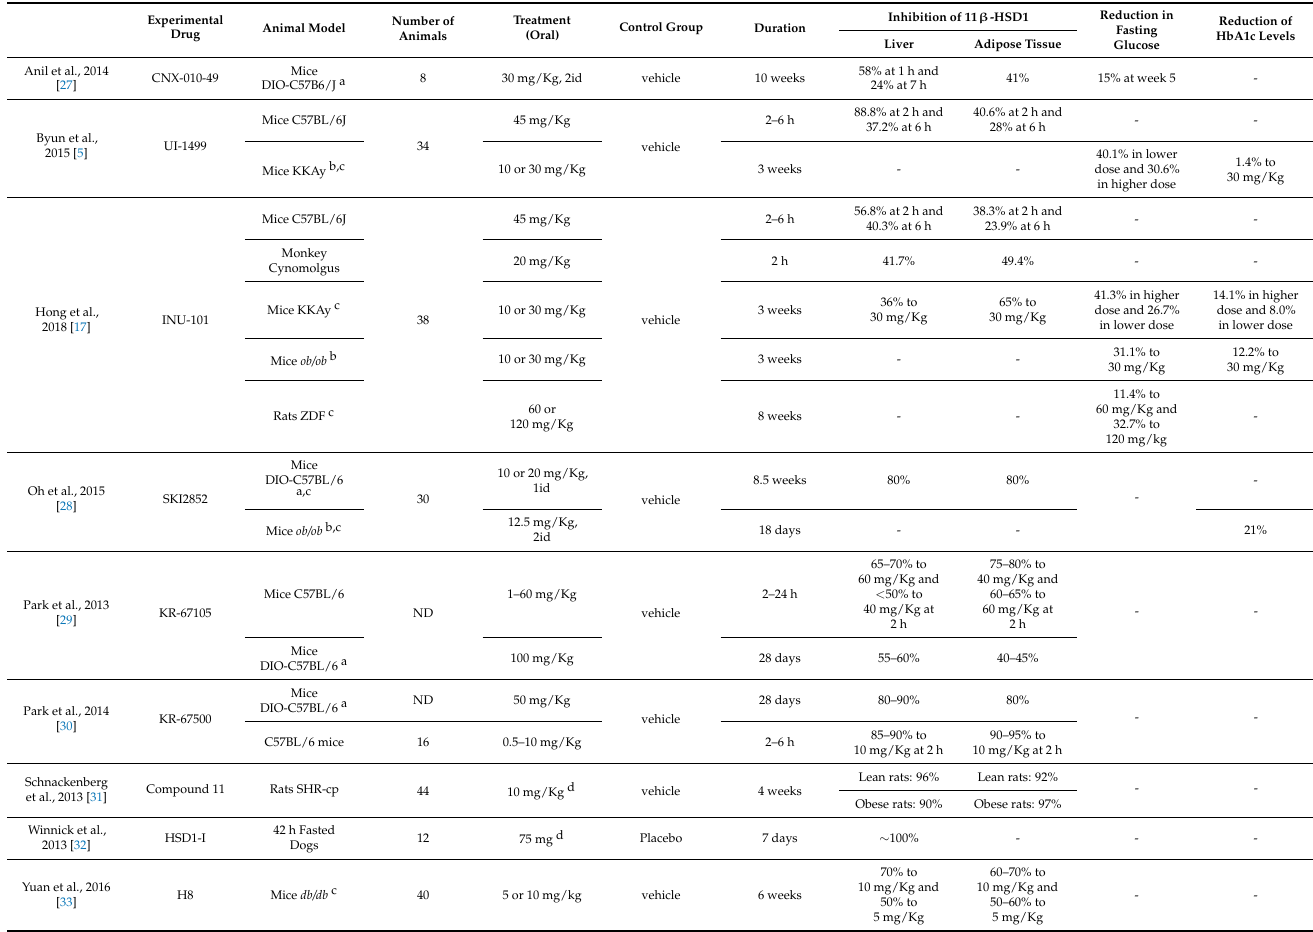
a Models of animals with diet-induced obesity, b Obese animal models, c Group of diabetic animals or subdivided into a group of diabetic animals, d Exception: Intravenous (IV) administration, ND = Not